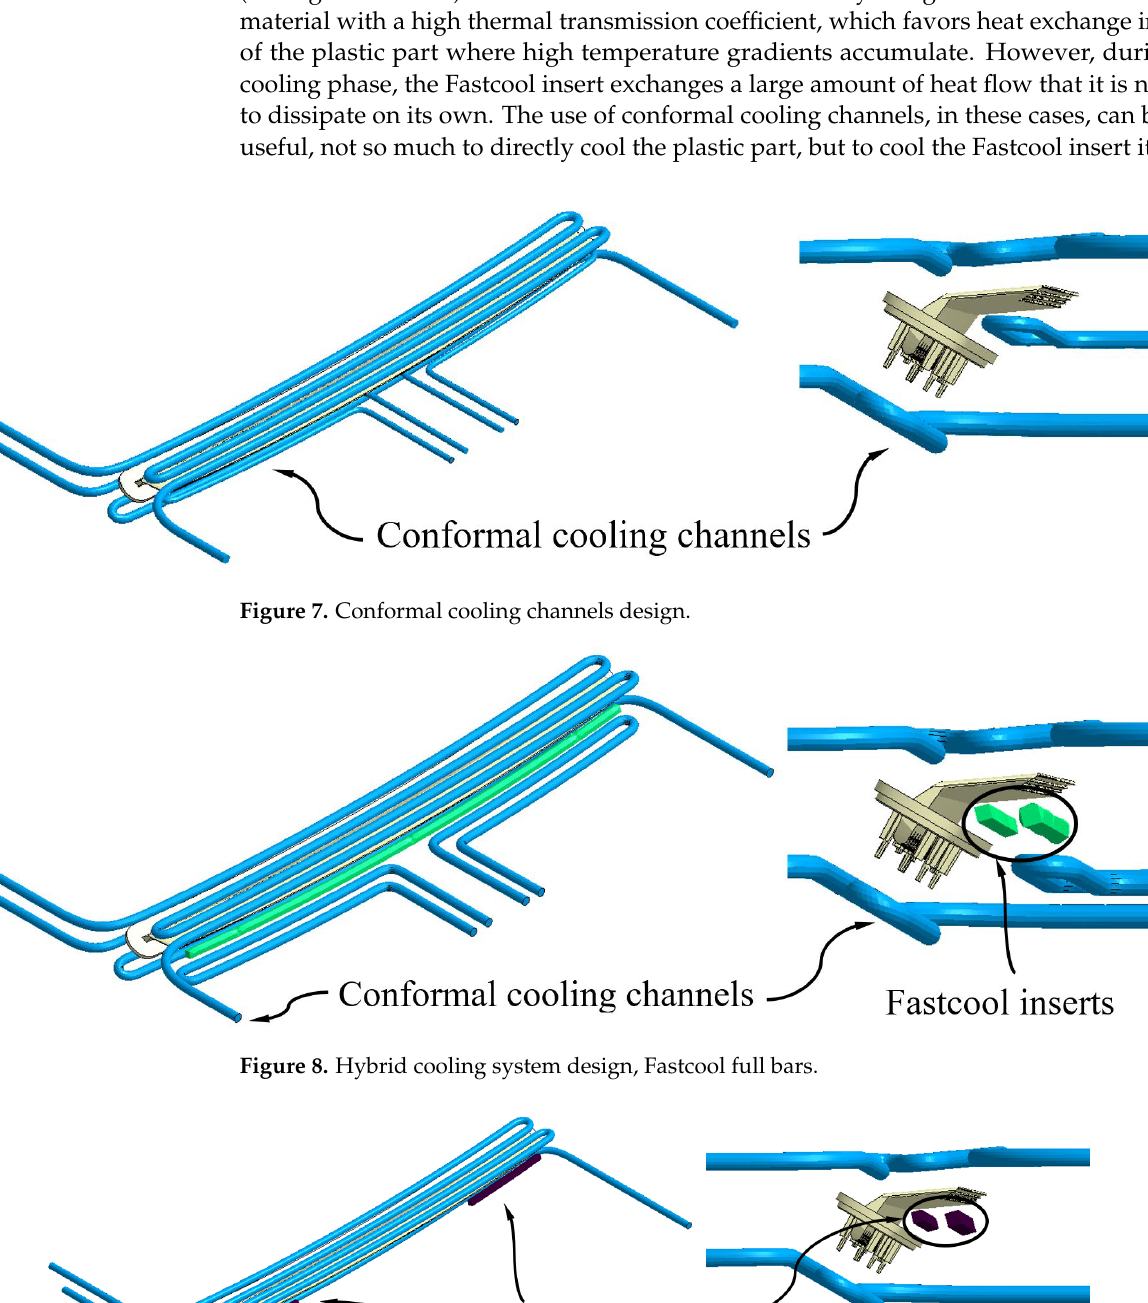
Figure 9. Hybrid cooling system design, dashed Fastcool bars. Table 7. Geometric variables of the traditional cooling system design. Description